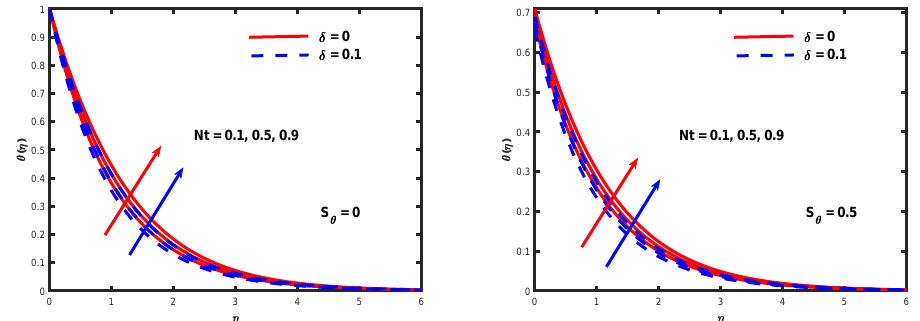
Figure 11. Influence of unsteady and thermophoresis parameter on θ